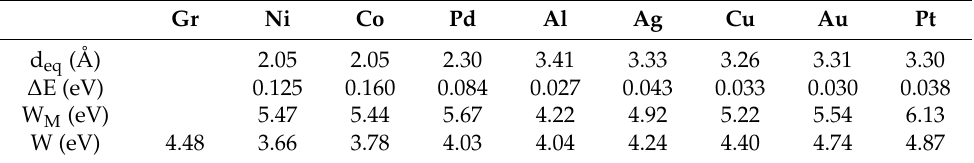
Table 4. Results of the calculations of Giovannetti et al. for the electronic characteristics of